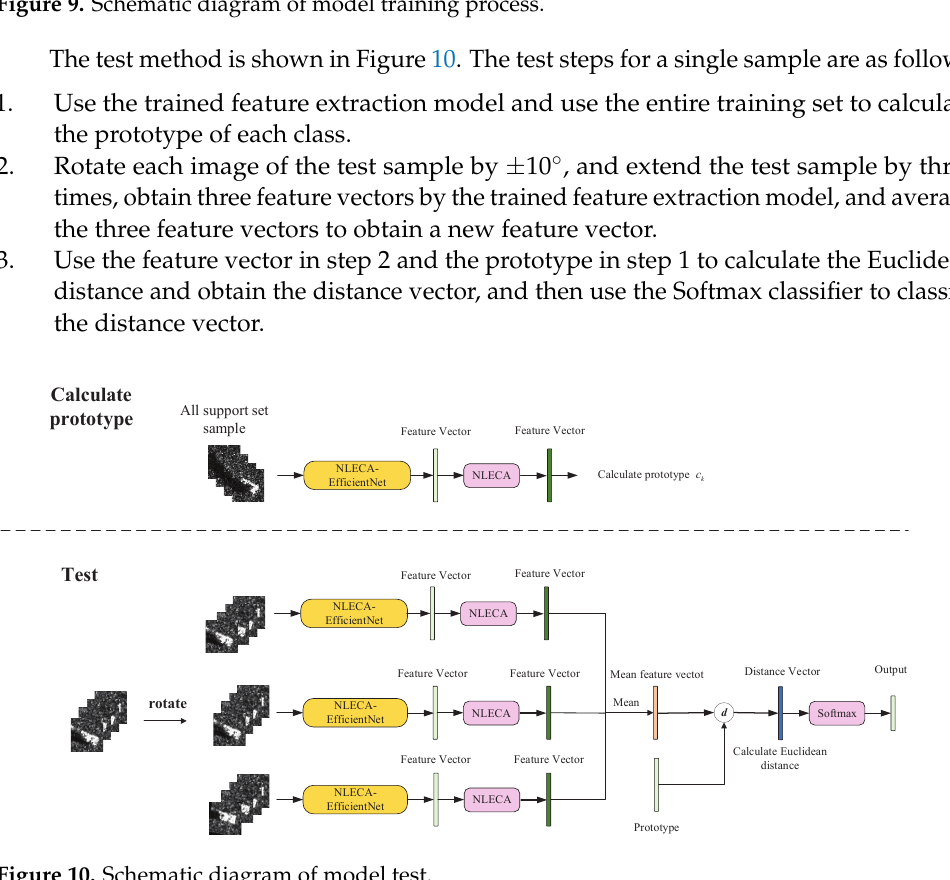
Figure 10. Schematic diagram of model